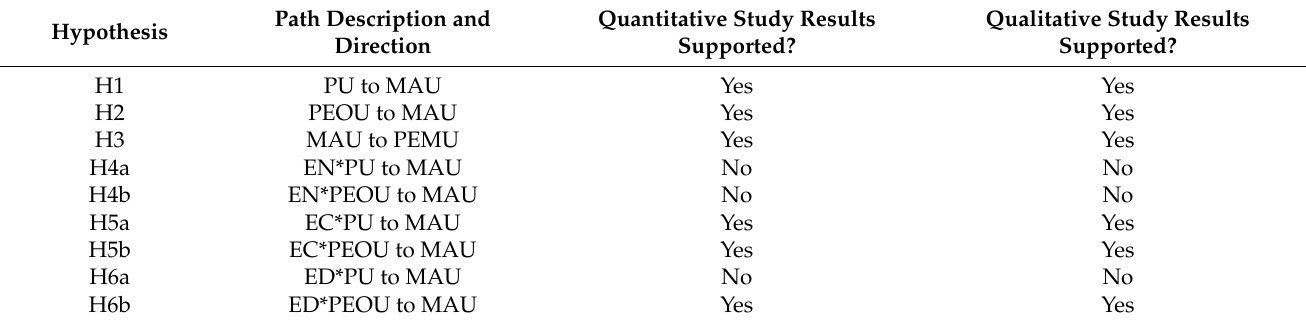
Table 5. Hypothesis Testing